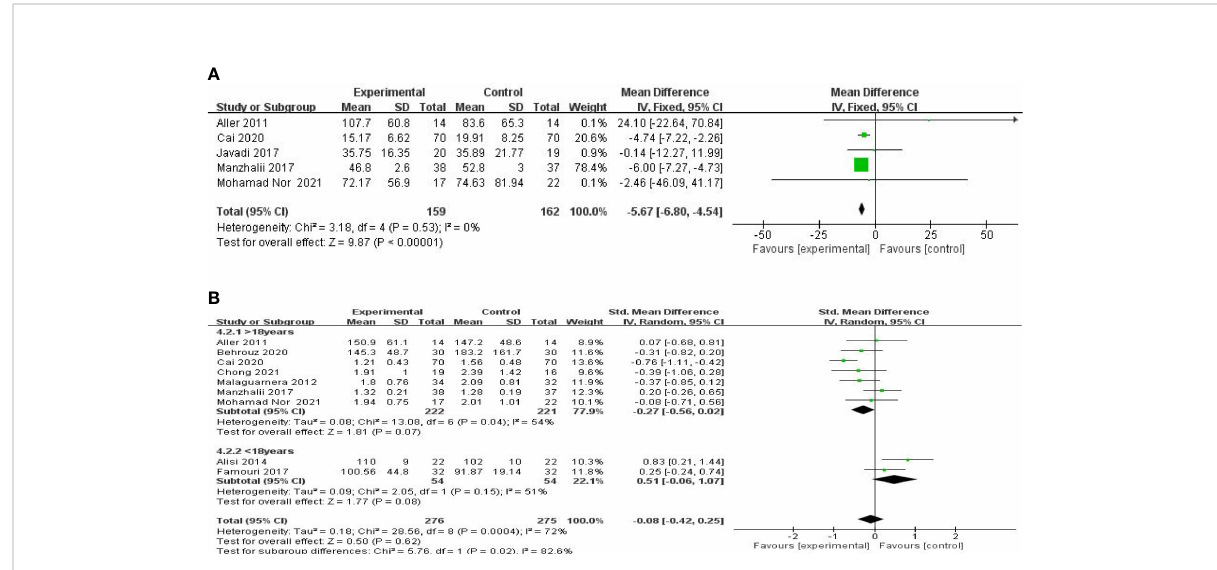
FIGURE 4 Forest plot of the effect of probiotic supplementation on GGT (A) . Forest plot of the effect of probiotic supplementation on TG (B)